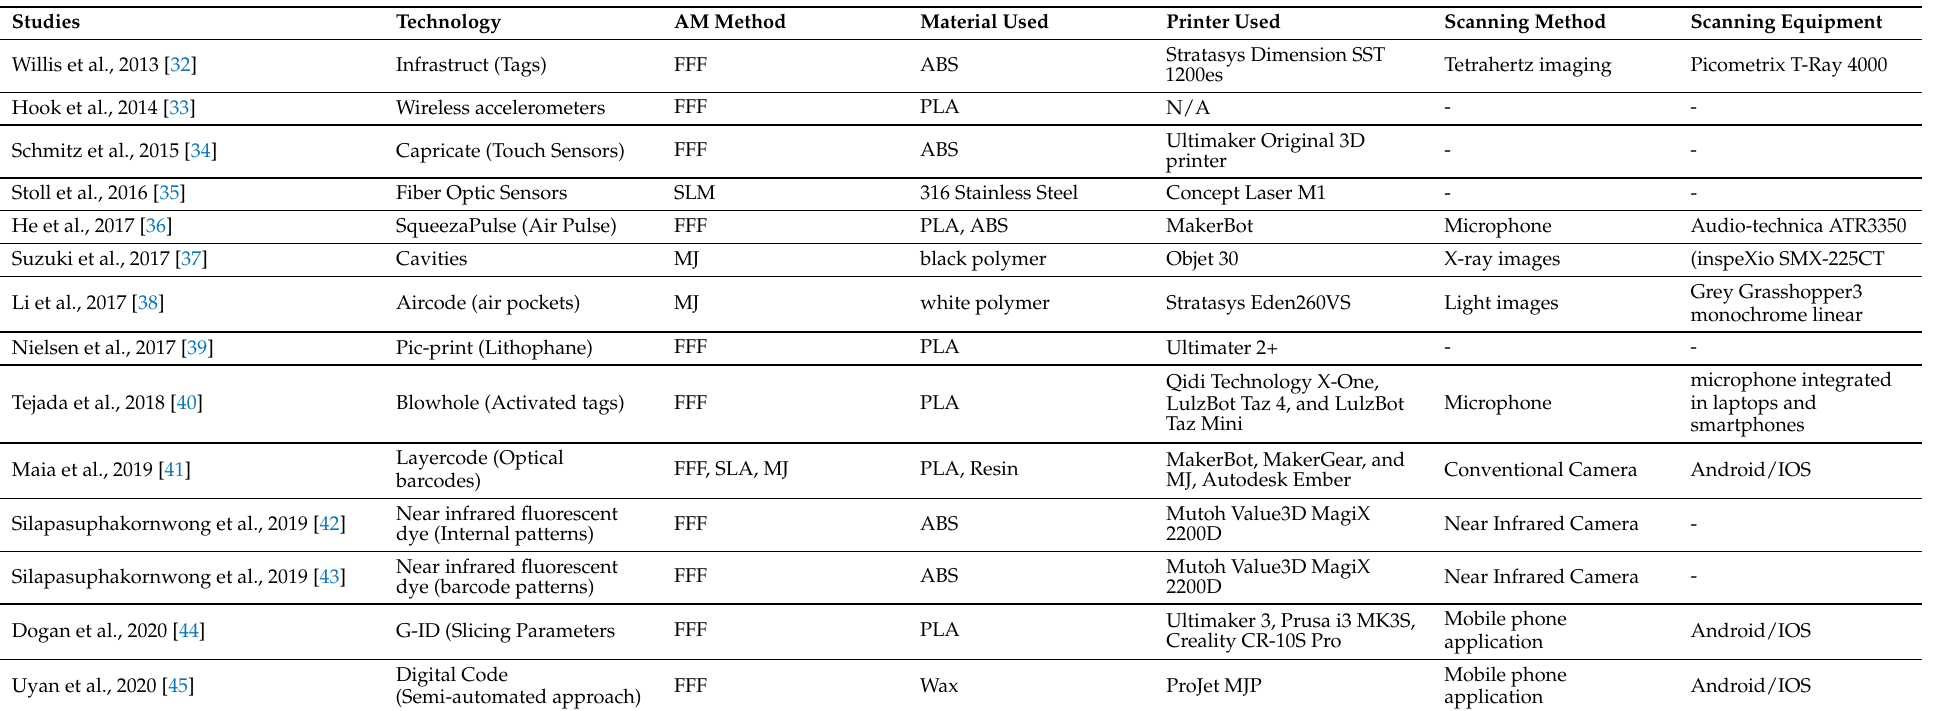
Table 4. Other AM-embedding approaches and